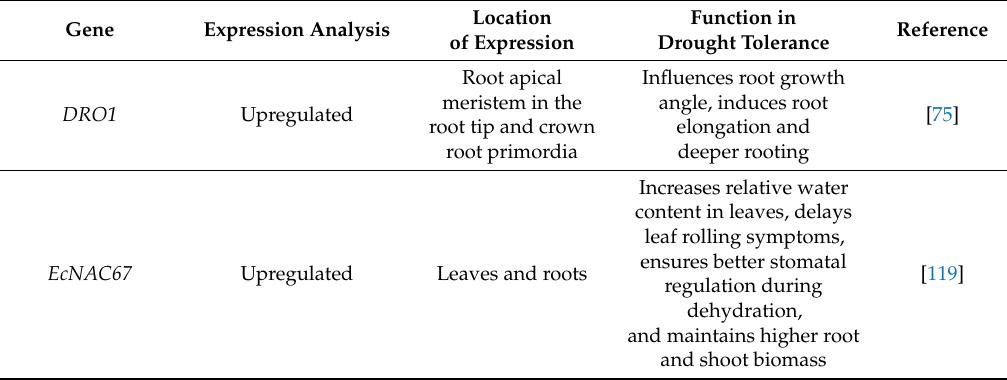
Table 1. Details of genes involved in drought